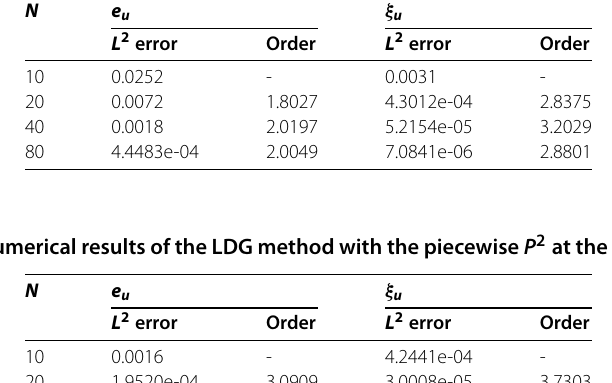
Table 5 The numerical results of the LDG method with the piecewise P 1 at the final time T = 1 N e u ξ u L 2 error Order